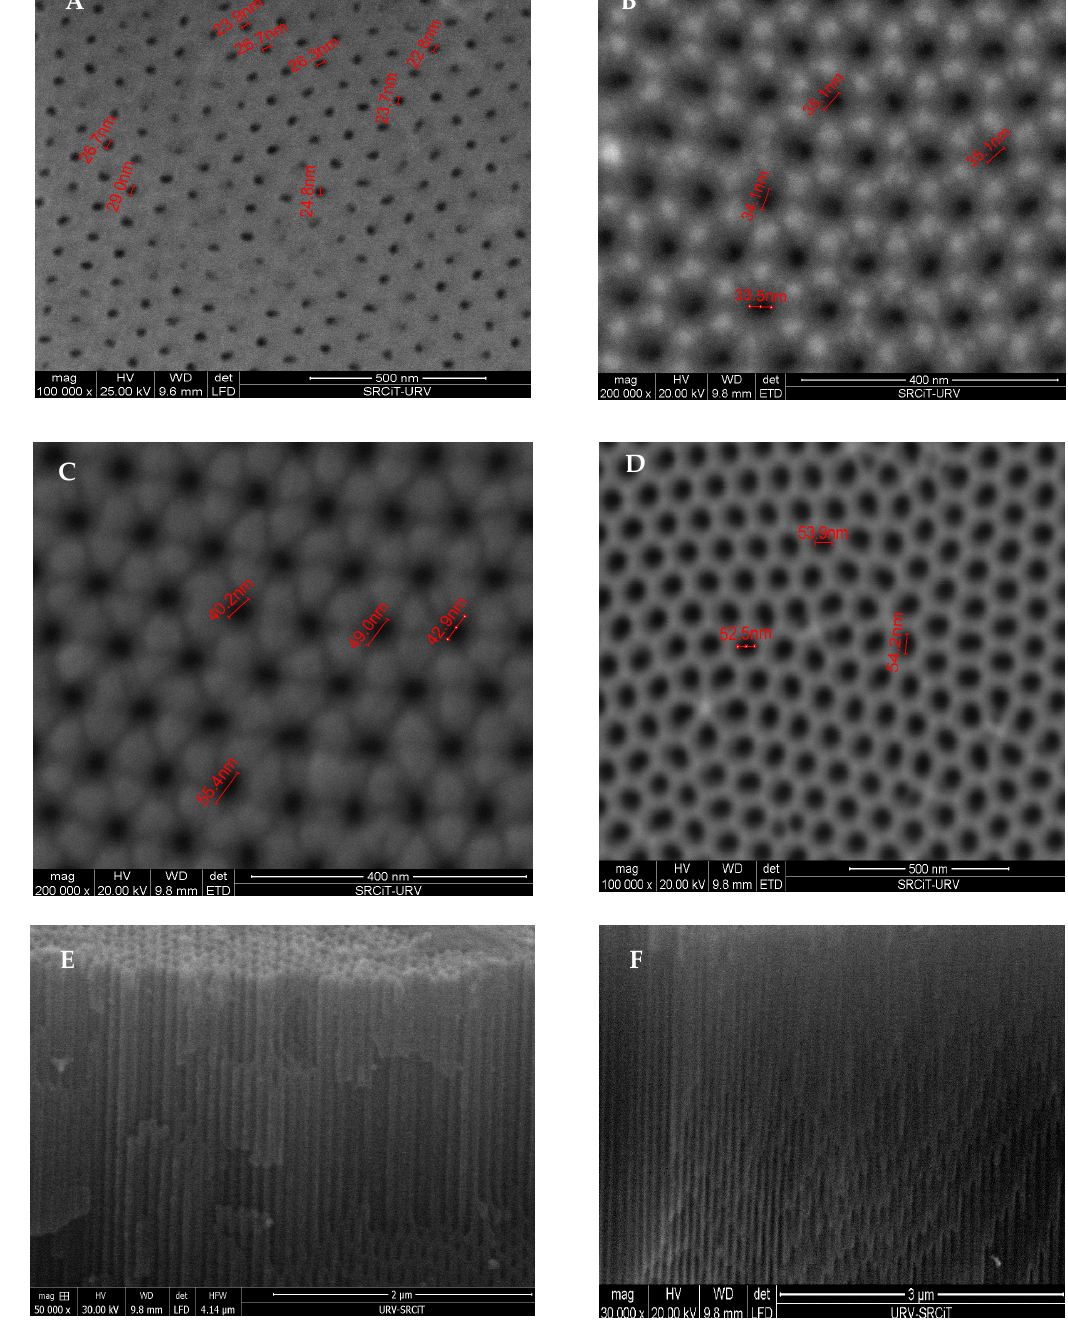
Figure 3. SEM images of an NAA: top views ( A – D ) and cross-sectional views ( E , F ).